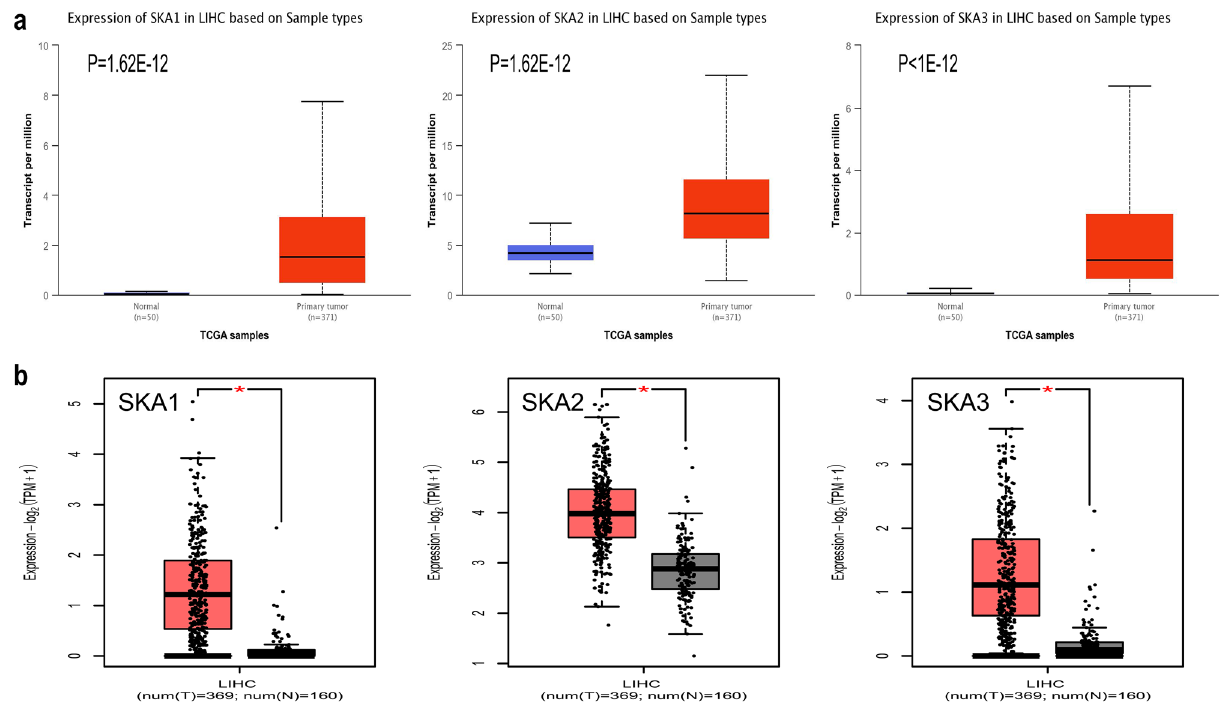
Figure 2. mRNA expression levels of SKAs in HCC patients. ( a ) mRNA expression levels of SKAs in HCC patients. (UALCAN). (red for tumor, blue for normal). ( b ) mRNA expression levels of SKAs in HCC patients. (GEPIA2). * P < 0.05. (red for tumor, black for normal). HCC hepatocellular